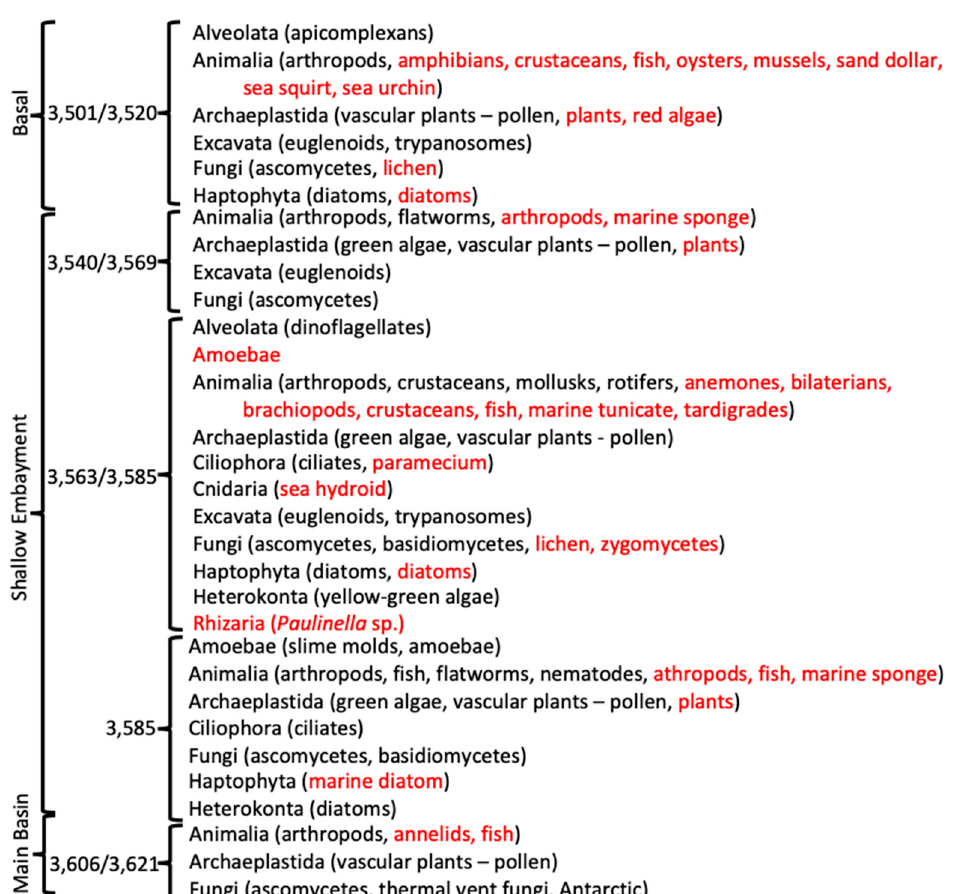
Figure 6. Condensed list of taxonomic groups of eukarya, based on sequence results. Black font indicates direct sequence BLAST matches to sequences from the NCBI database. Red font indicates eukaryotic taxa that have been reported to be associated with bacteria or other eukaryotic organisms.